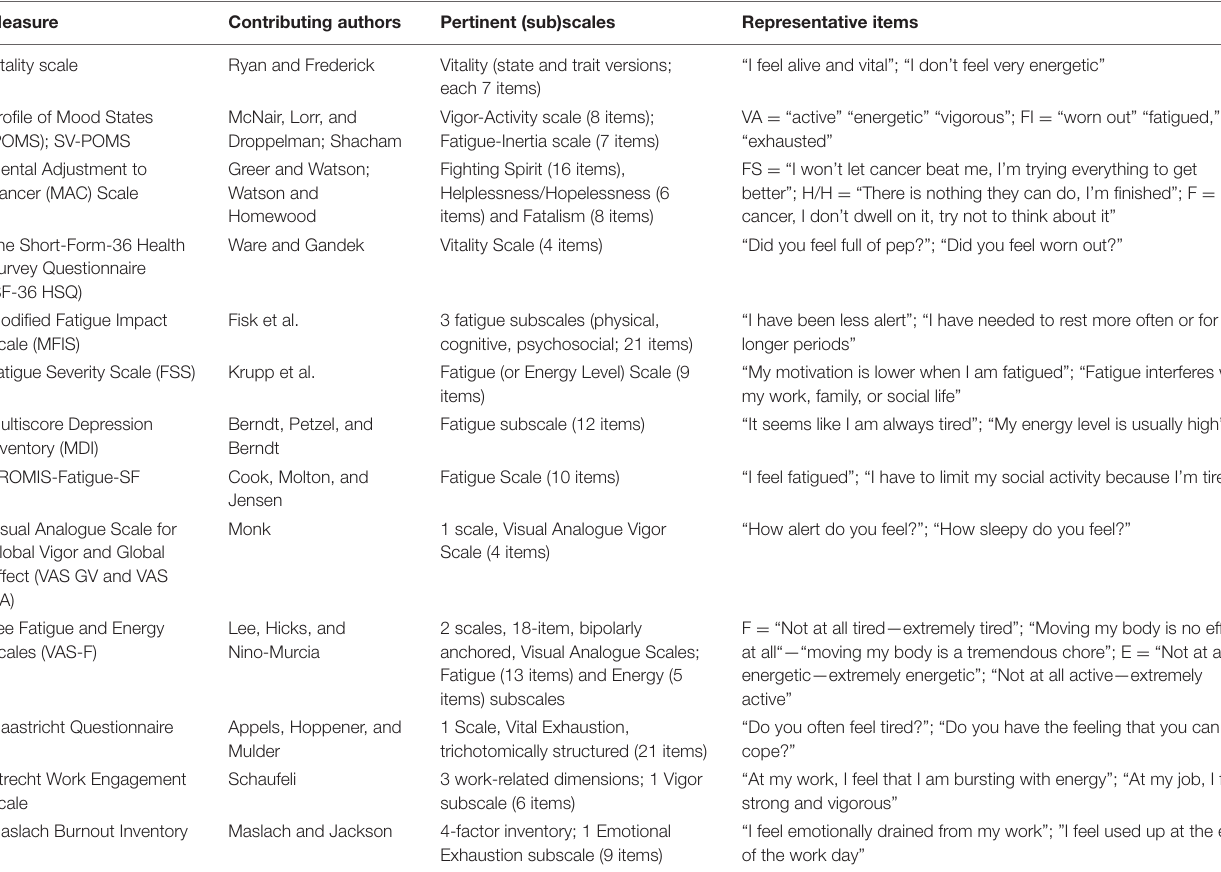
TABLE 2 | Primary measures of psychological